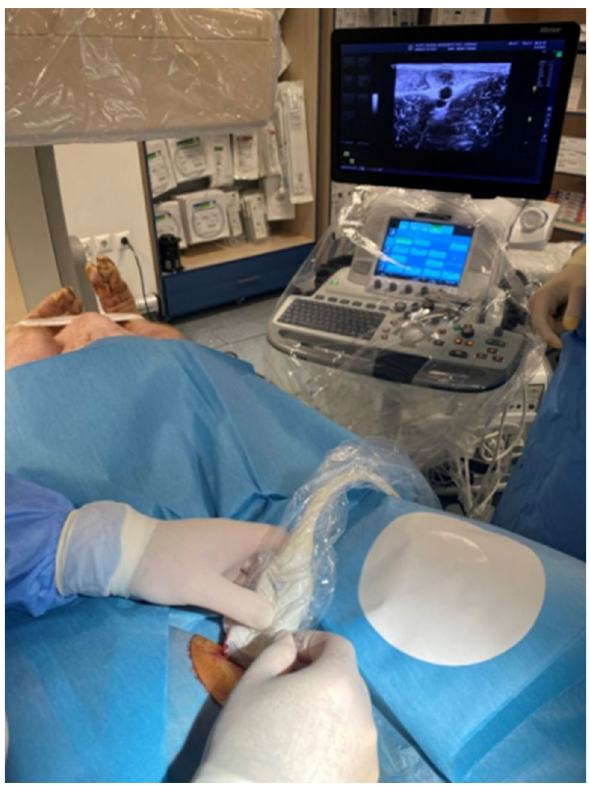
Figure 2. Ultrasonography-guided puncture of the right